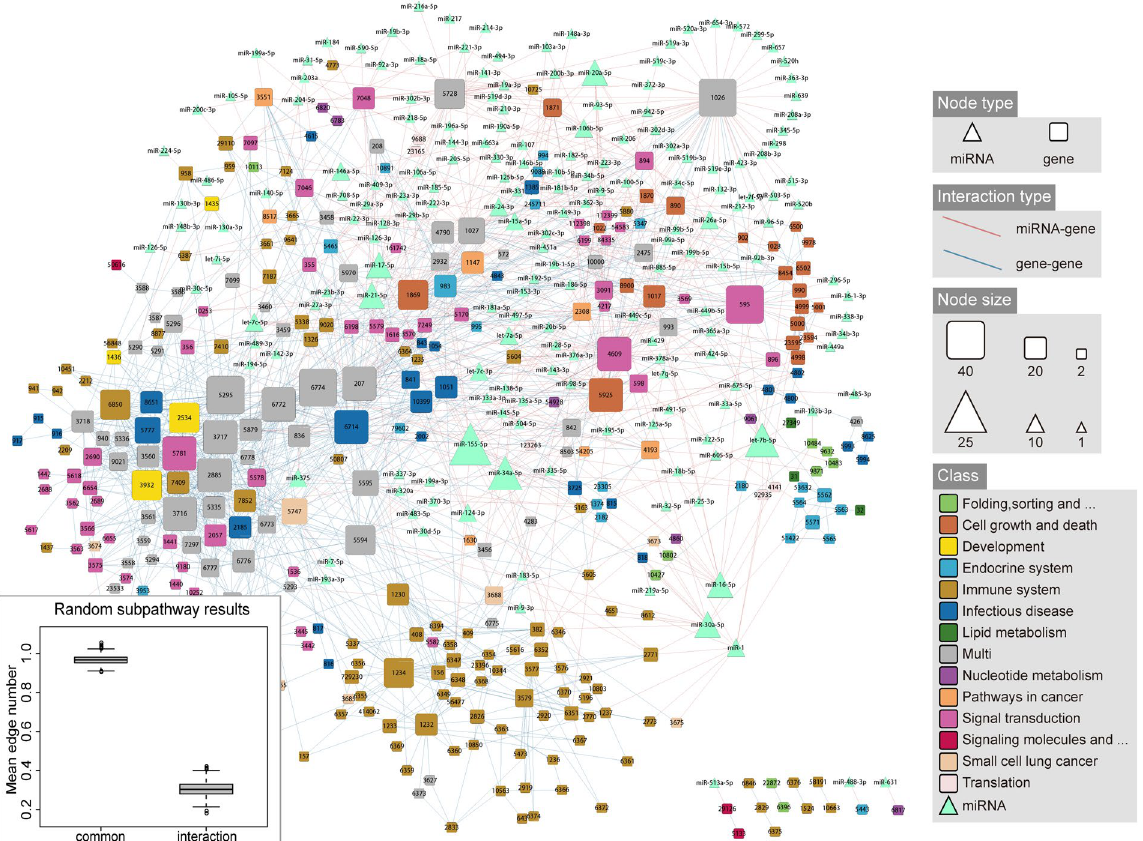
Figure 5. The miRNA–gene interaction network. The triangles and rectangles in the interaction network designate miRNAs and genes, respectively. miRNA and gene node sizes were proportional to the degree of the nodes. Gene nodes were colored according to their pathway categories, which were derived from the KEGG database. The random subpathway results are shown in the lower left